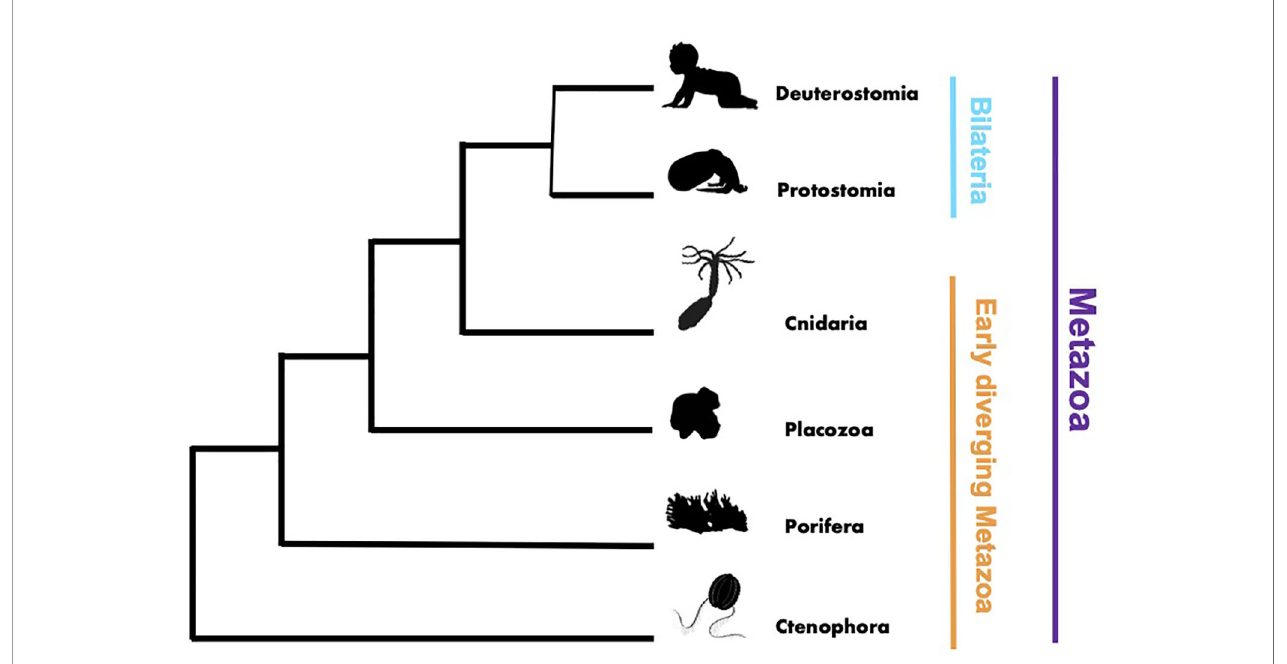
FIGURE 1 | Phylogenetic tree rendering showing the broad evolutionary relationships within the